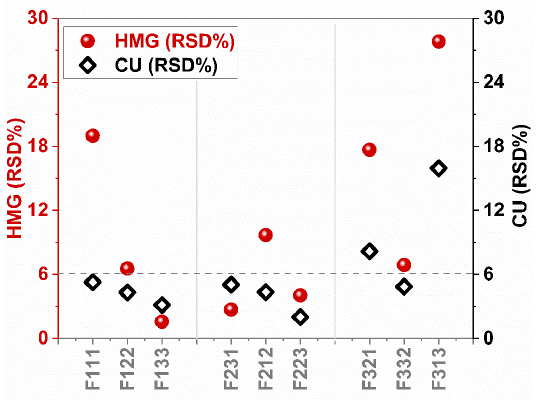
Figure 6. Comparison of homogeneity and content uniformity tests with respect to RSD% of the corresponding drug amounts. Final drug concentration: ~23 wt%. The horizontal line indicates the acceptable RSD for HMG and CU.